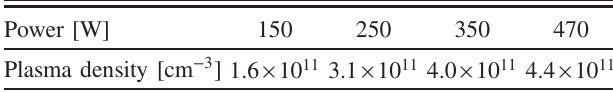
TABLE IV. Estimated lower limit for the charge breeder helium plasma (electron) density as a function of microwave power. Power [W] 150 250 350 470